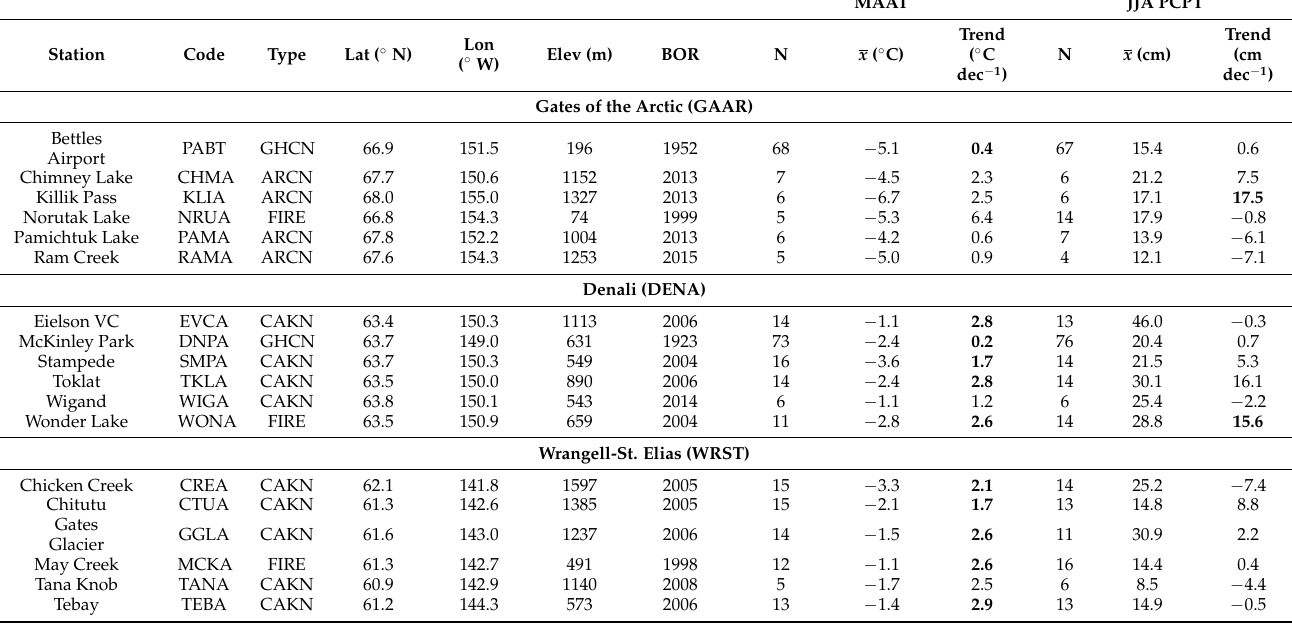
Table 1. Station information for locations in or near Gates of the Arctic (GAAR), Denali (DENA) and Wrangell-St. Elias (WRST). This includes each station’s: identifier (Code), source (Type), latitude (Lat), longitude (Lon), elevation (Elev), beginning year of available record (BOR) and number of valid years (N), mean ( x ) and trend of mean annual air temperature (MAAT) and summer precipitation (JJA PCPT). Significant trends at the 95% confidence level are in bold